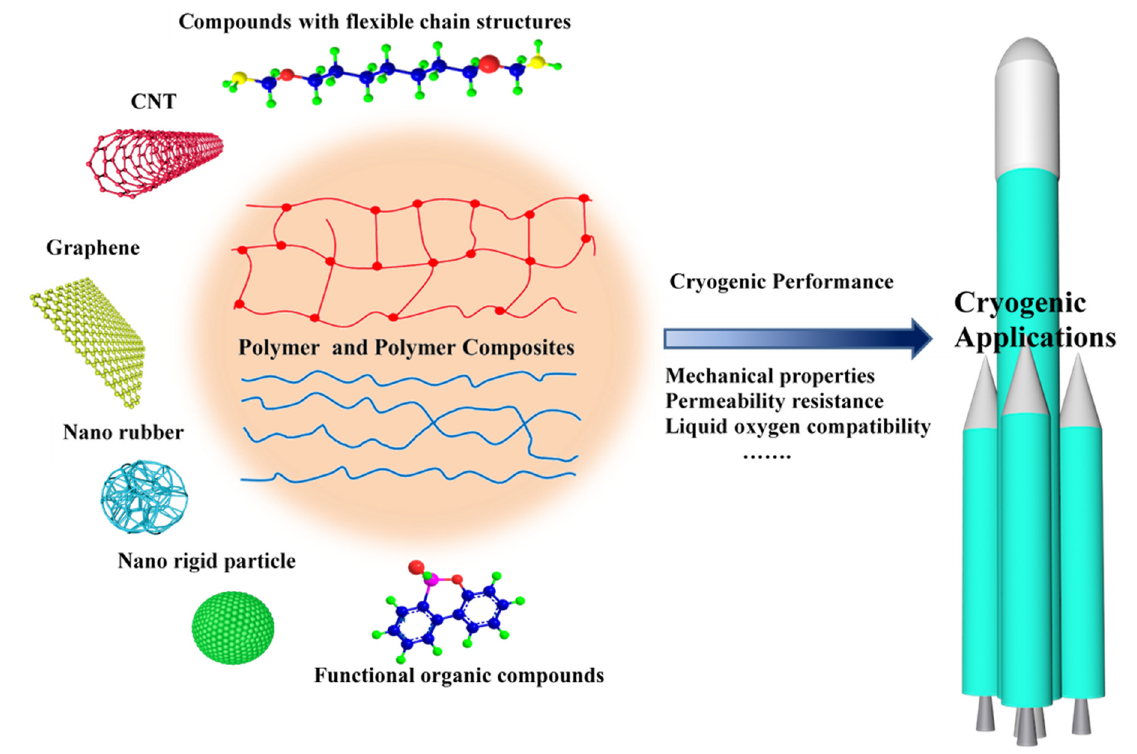
Figure 2. Schematic illustration of the main contents in this review, including the cryogenic performance of thermoset, thermoplastic polymer and the modified polymer by introducing various modifiers, such as graphene, carbon nanotubes, nanoparticle, rubber, compounds with flexible chain structures and functional organic compounds.